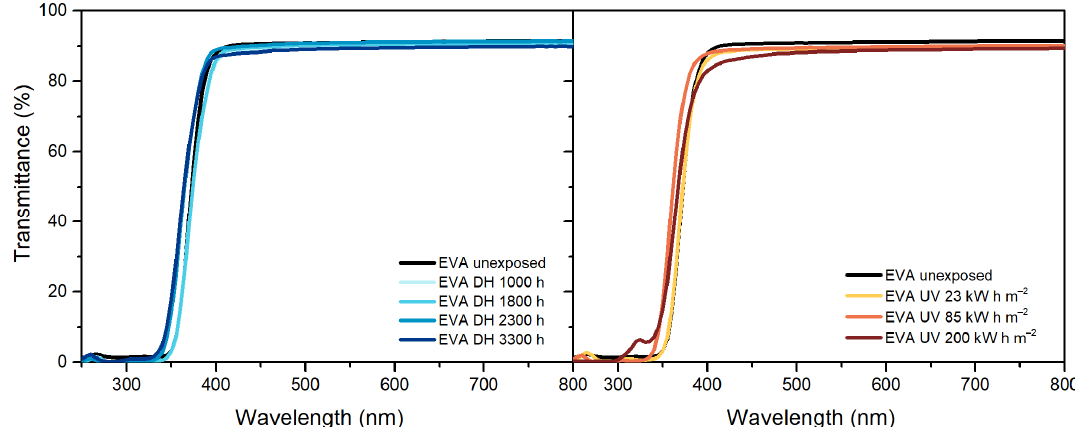
Figure 1. Ultraviolet-Visible (UV-Vis) spectra of ethylene vinyl acetate (EVA) unexposed, exposed to damp heat (DH) (left) and ultraviolet (UV) test (right).